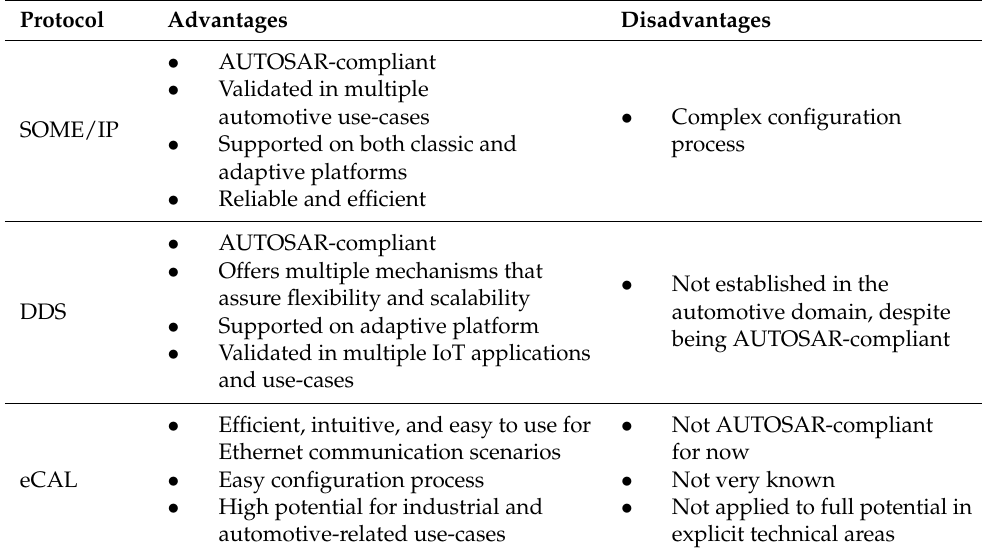
Table 1. Advantages and disadvantages related to SOME/IP, DDS, and